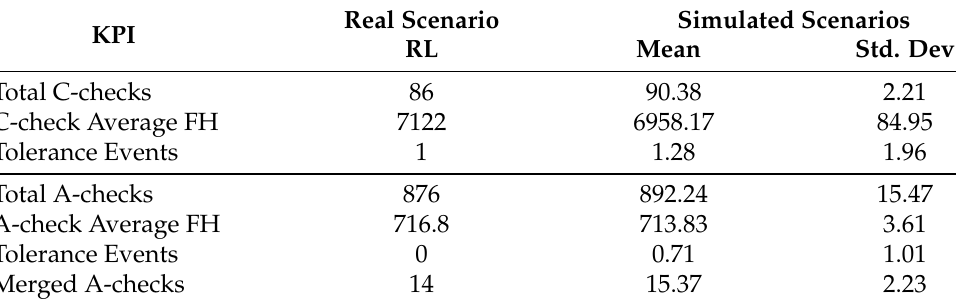
Table 4. The results obtained with simulated